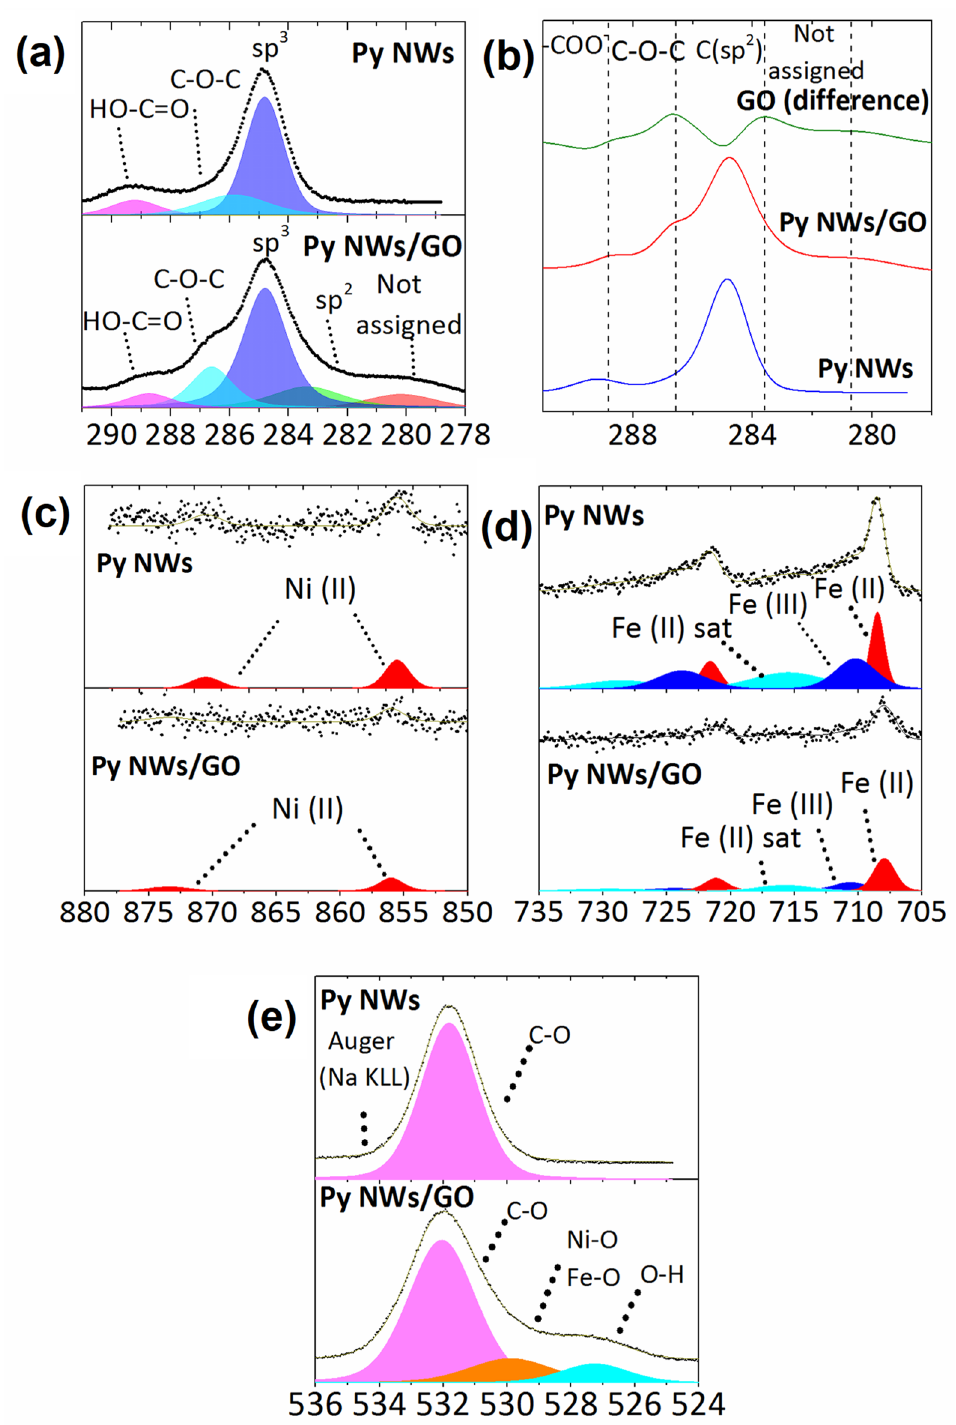
Figure 6. XPS spectra (Intensity in arb. units vs. Binding energy in eV) of Py NWs and Py NWs/GO for ( a ) C1s, ( b ) difference of C1s, ( c ) Ni2p, ( d ) Fe2p and ( e )